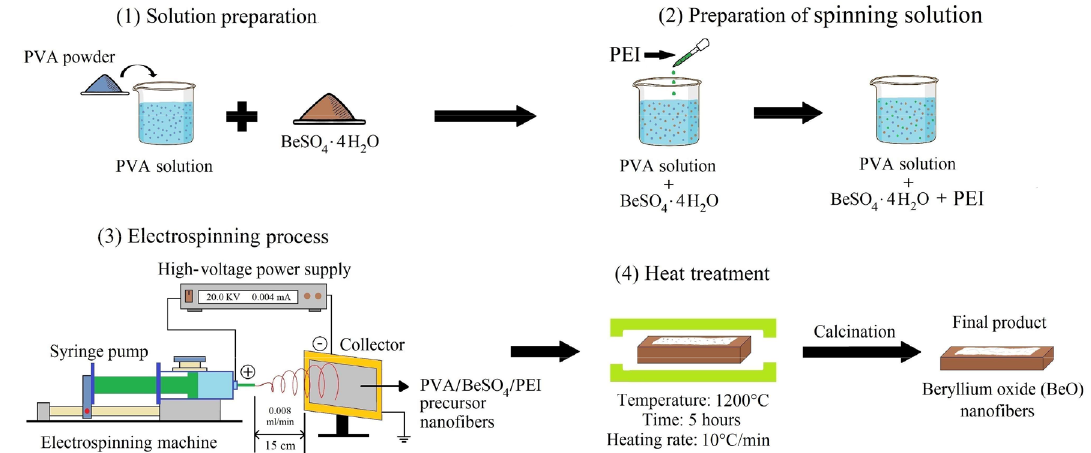
Fig. 1 Experimental scheme of preparation of BeO nanofiber